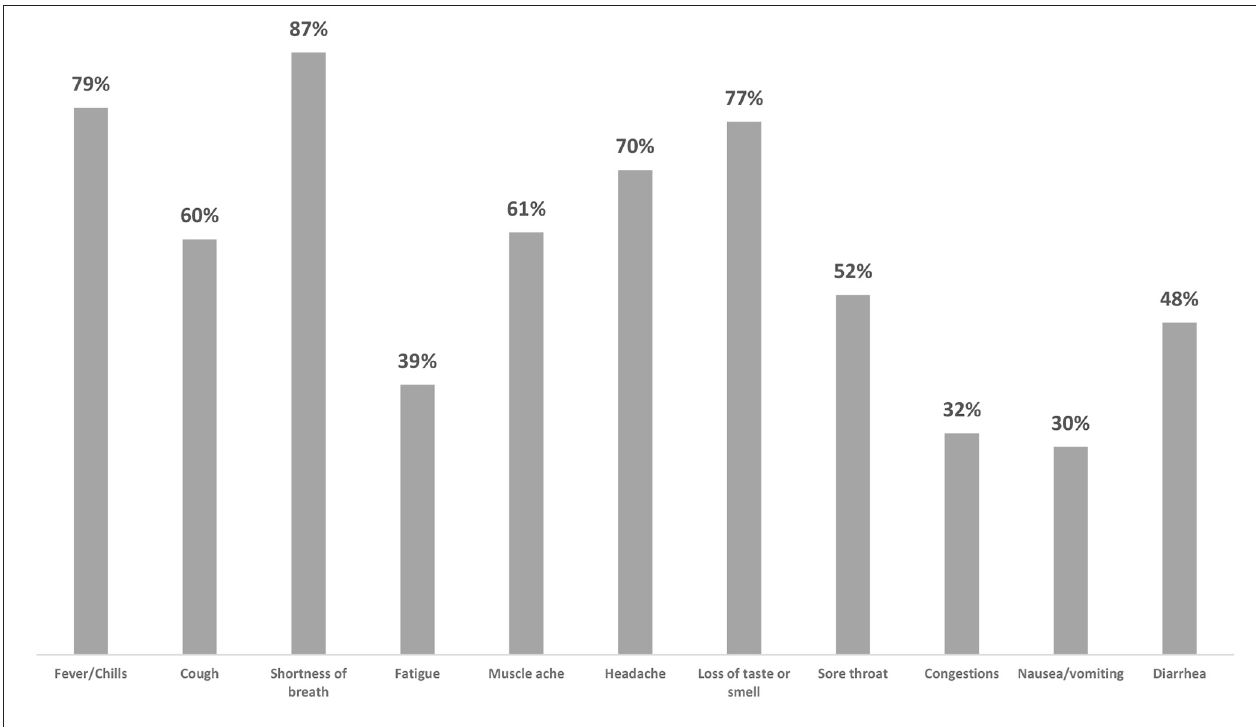
FIGURE 2 | What are the symptoms of COVID-19?